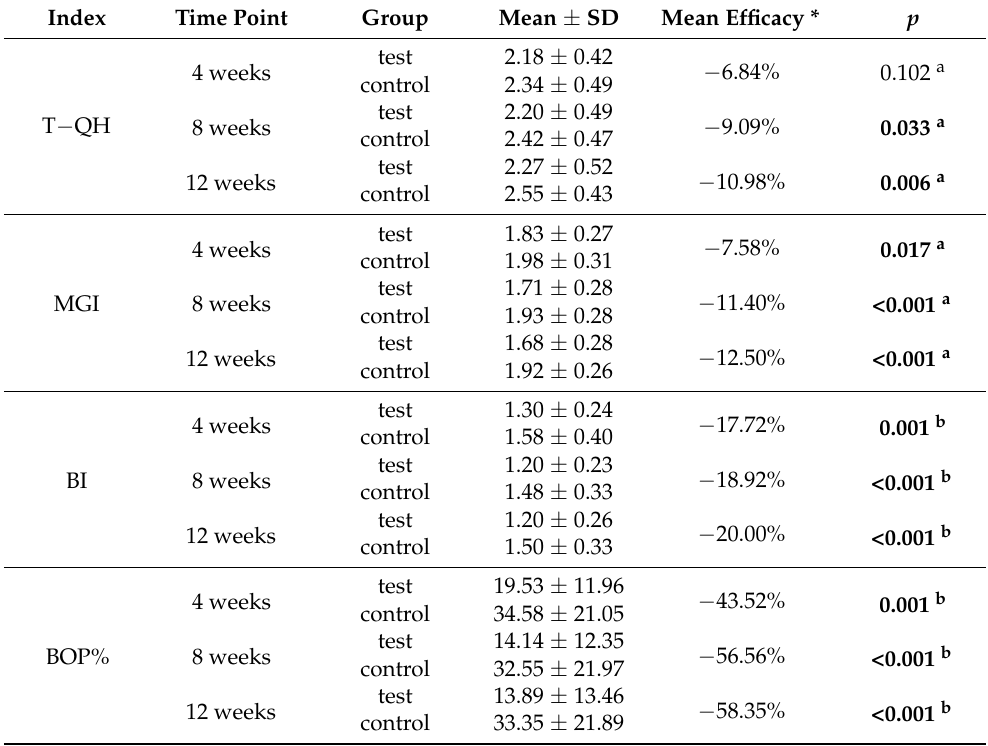
Table 2. The periodontal indices for two groups at follow-up (full analysis set).